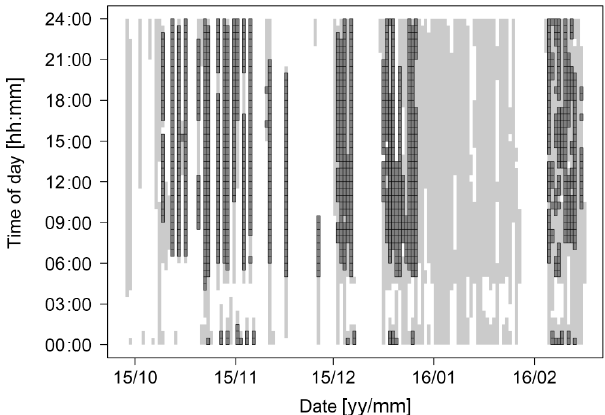
Figure 4. Overview of the field campaign period. Time periods when the QCLAS was in operation and NO 2 data were transmitted to the database are depicted in light gray. Thirty minutes periods for which the QCLAS delivered high quality NO 2 data and the tram was in regular operation are depicted in dark